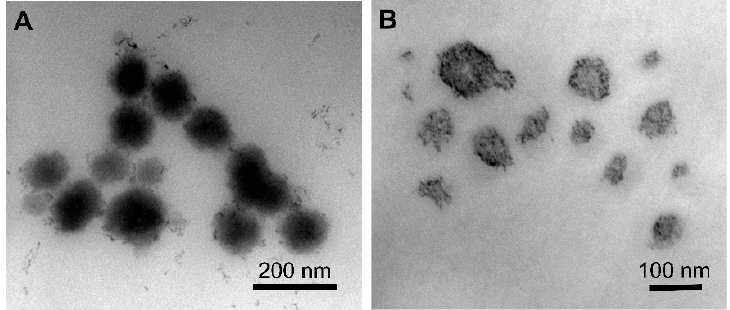
Figure 3. TEM images of ( A ) F2-NC and ( B ) F2-NS. F2-NC is characterized by a spherical morphology and core/shell architecture appearing as a dark core surrounded by a lighter outer layer, whereas F2-NS appeared as polydisperse matrix-like particles.